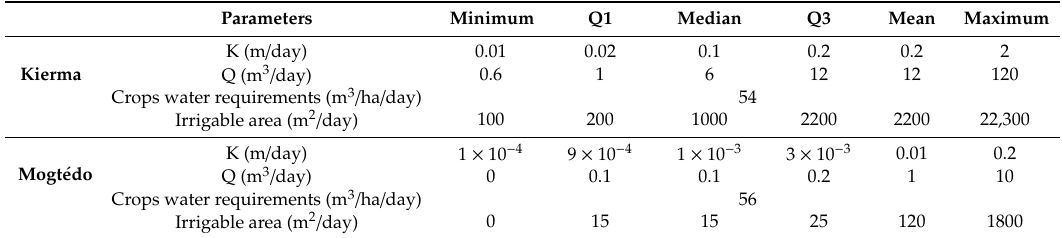
Table 4. Estimation of hand-dug well yield, crops water requirements and irrigable surface area. Parameters Minimum Q1 Median Q3 Mean Maximum K (m / day) 0.01 0.02 0.1 0.2 0.2 2 Kierma Q (m 3 / day) 0.6 1 6 12 12 120 Crops water requirements (m 3 / ha / day) 54 Irrigable area (m 2 / day) 100 200 1000 2200 2200 22,300 K (m / day) 1 × 10 − 4 9 × 10 − 4 1 × 10 − 3 3 × 10 − 3 0.01 0.2 Mogt é do Q (m 3 / day) 0 0.1 0.1 0.2 1 10 Crops water requirements (m 3 / ha / day) 56 Irrigable area (m 2 / day) 0 15 15 25 120 1800 Q1: the first and Q3 the third